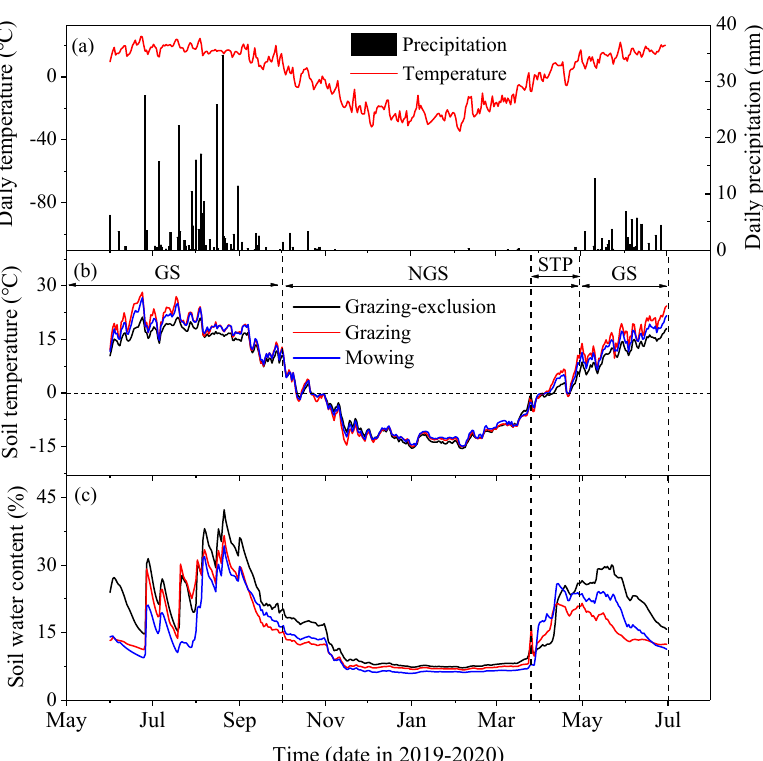
Figure 1. Daily averages of air temperature and precipitation ( a ), soil (5 cm in depth) temperature ( b ) and soil (10 cm in depth) water content ( c ) during the entire experiment period at the grazing- exclusion, grazing and mowing sites. GS: growing season. NGS: non-growing season. STP: spring thaw period.